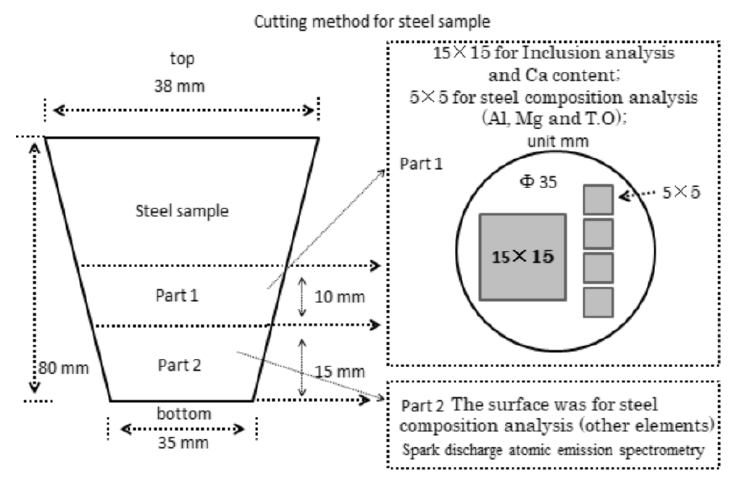
Figure 3. Cutting method of the steel sample.